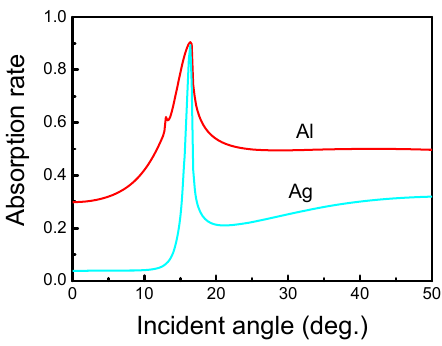
Fig. 2. Angle spectra of absorption rate at 450 nm.